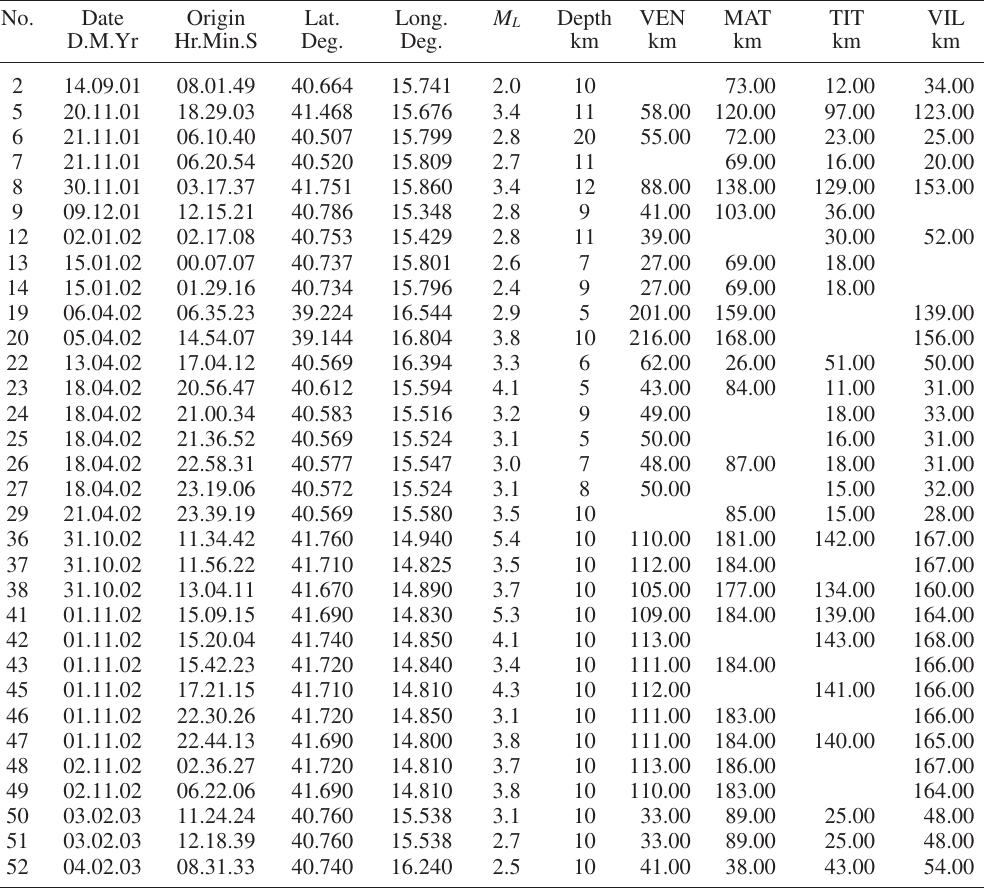
Table I. Earthquake coordinates and hypocentral